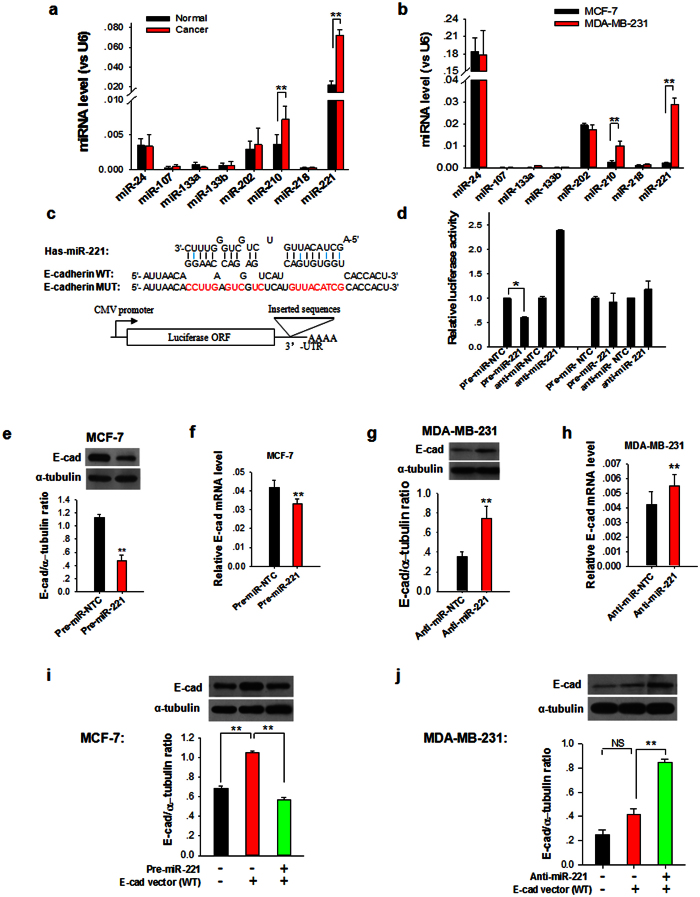
Posttranscriptional regulation of E-cadherin expression in breast cancer cells by miR-221.(a) Levels of all predicted miRNAs targeting E-cadherin ORF in paired breast cancer and normal tissue samples. (b) Levels of all predicted miRNAs targeting E-cadherin ORF in MCF-7 and MDA-MB-231 cells. (c) Schematic depiction of the Luciferase reporter consisting of full-length of E-cadherin ORF. The hypothetical duplexes formed by wild-type E-cadherin ORF and miR-221 were indicated. The mutated sites in E-cadherin MUT were marked in red. (d) Luciferase activity in MCF-7 cells transfected with either WT or Mut E-cadherin ORF plus pre-miR-221, anti-miR-221 or scrambled RNA oligonucleotides (control-pre-NTC). Cells were assayed using a luciferase assay kit 24 h post-transfection. (e,f) Overexpression of miR-221 in MCF-7 cells strongly reduced the expression of E-cadherin protein (e) and resulted in small but significant reduction in E-cadherin mRNA levels (f). (g,h) Knockdown of miR-221 level in MDA-MB-231 cells using anti-miR-221 ASO significantly induced E-cadherin protein expression (g) and resulted in E-cadherin mRNA slightly elevation (h). (i) E-cadherin protein levels in MCF-7 cells transfection with or without WT E-cadherin ORF and pre-miR-221. (j) E-cadherin protein levels in MDA-MB-231 cells transfected with or without WT E-cadherin ORF and anti-miR-221 ASO. Results are presented as the mean ± SEM (n = 3). NS, no significant difference, *P < 0.05. **P < 0.01.